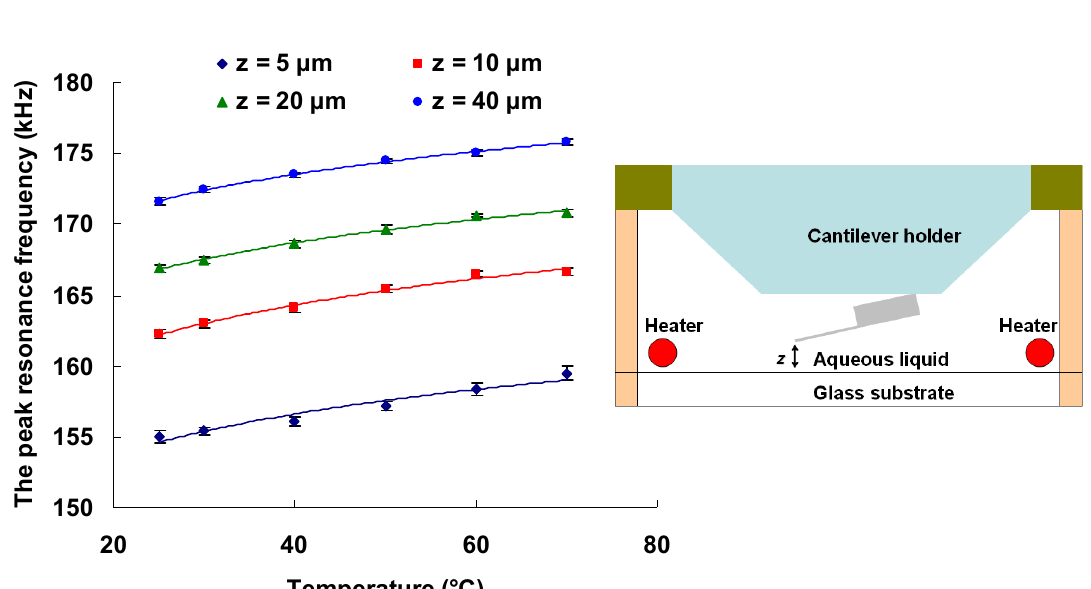
Figure 1. Experimental near-wall correlation of the microcantilever peak resonance response frequency with aqueous medium temperature at four different separation distances ( z = 5, 10, 20, and 40 µm) between the lower end of the cantilever and the glass substrate surface